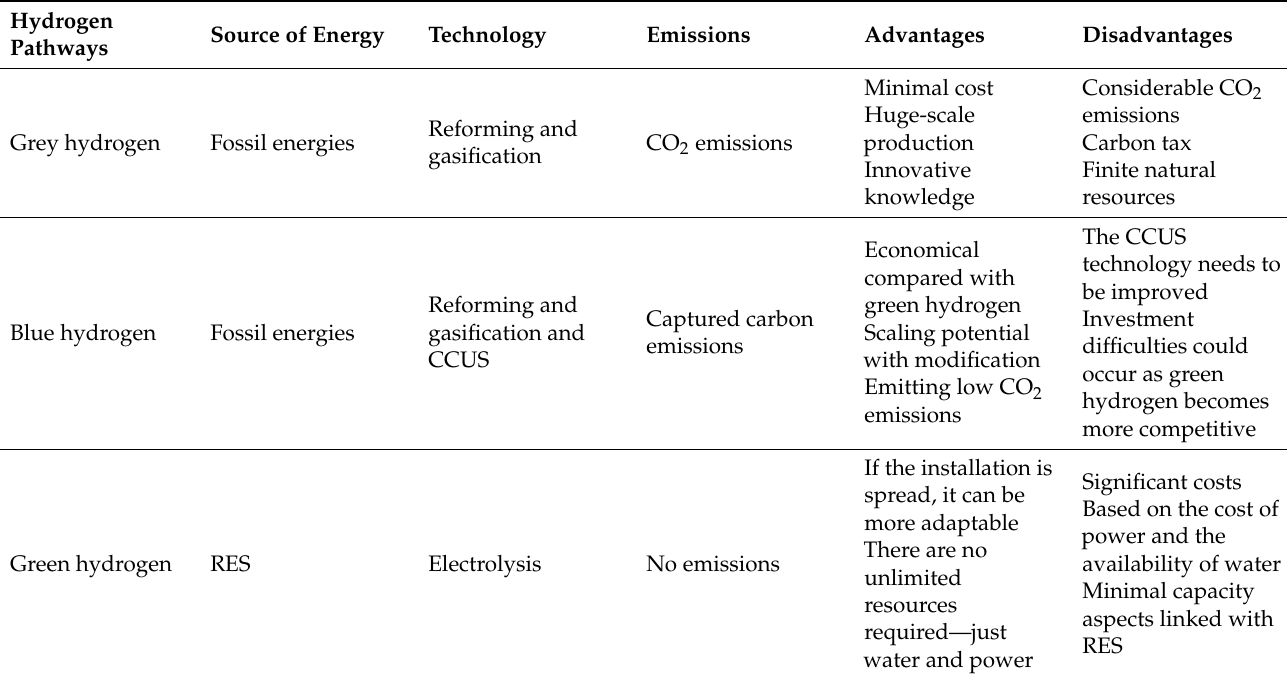
Table 5. Hydrogen production pathways and technologies. Reprinted with permission